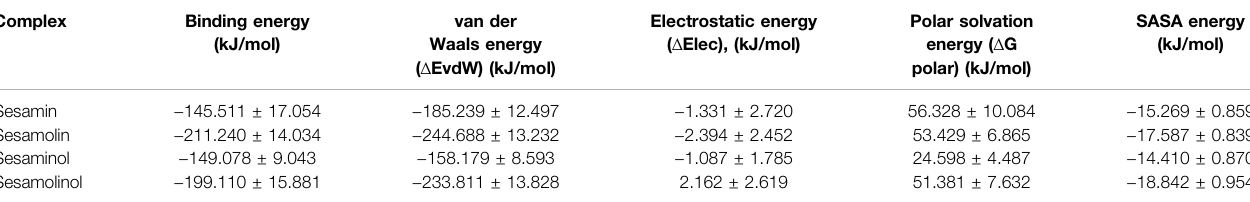
TABLE 3 | Calculated total binding energy, van der Waals energy, electrostatic energy, polar solvation energy, and SASA energy of the docking complexes. Complex Binding energy van der (kJ/mol) Waals energy ( Δ EvdW)